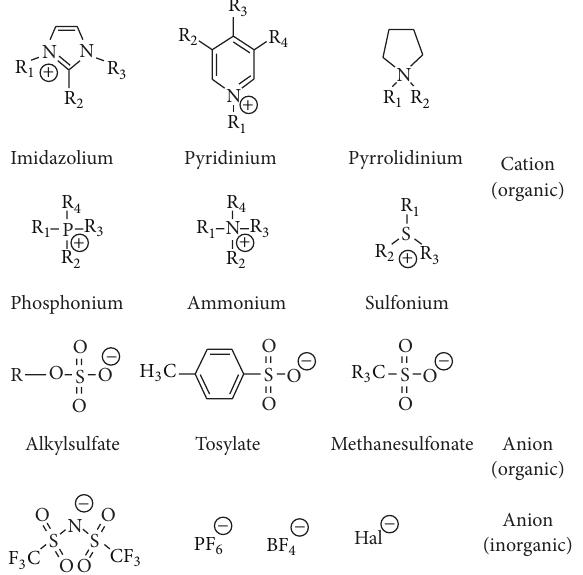
Figure 1: Typical structures that combine organic cations with inorganic or organic anions